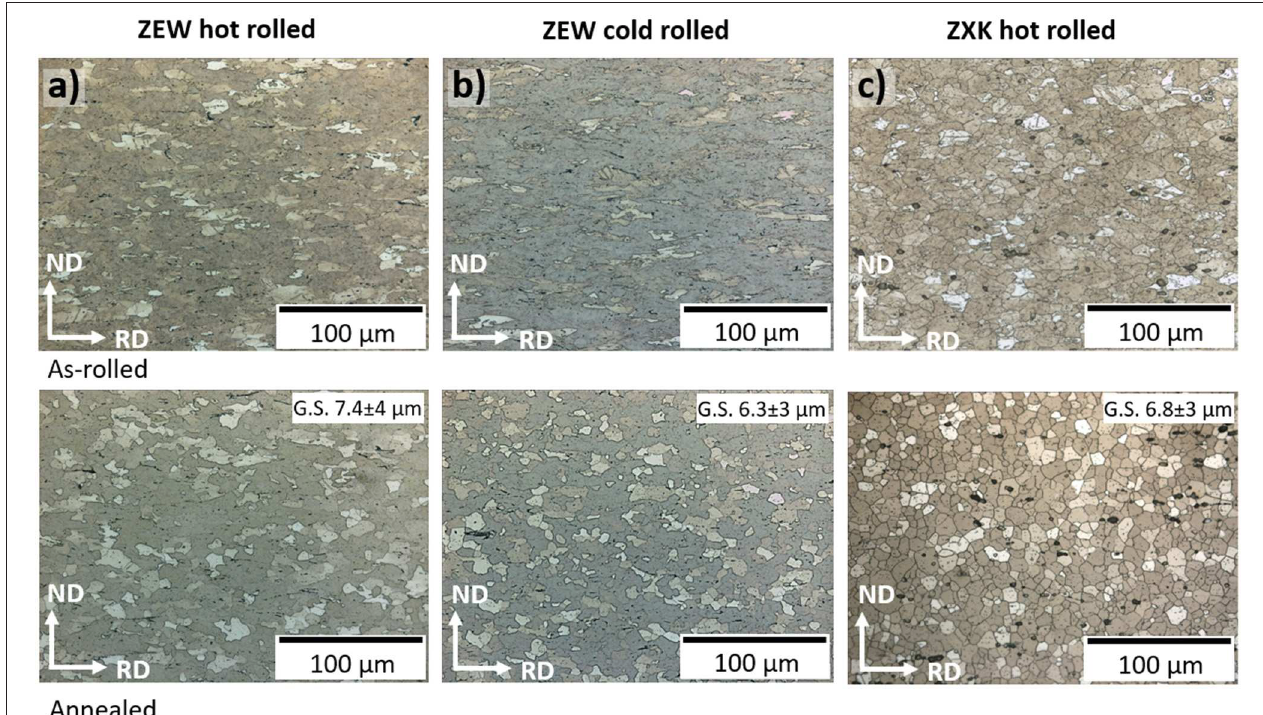
FIGURE 1 | Optical microstructures of (a) hot rolled ZEW200 alloy, (b) cold rolled ZEW200 alloy, and (c) hot rolled ZXK alloy in as-rolled (top) and annealed (bottom) conditions,